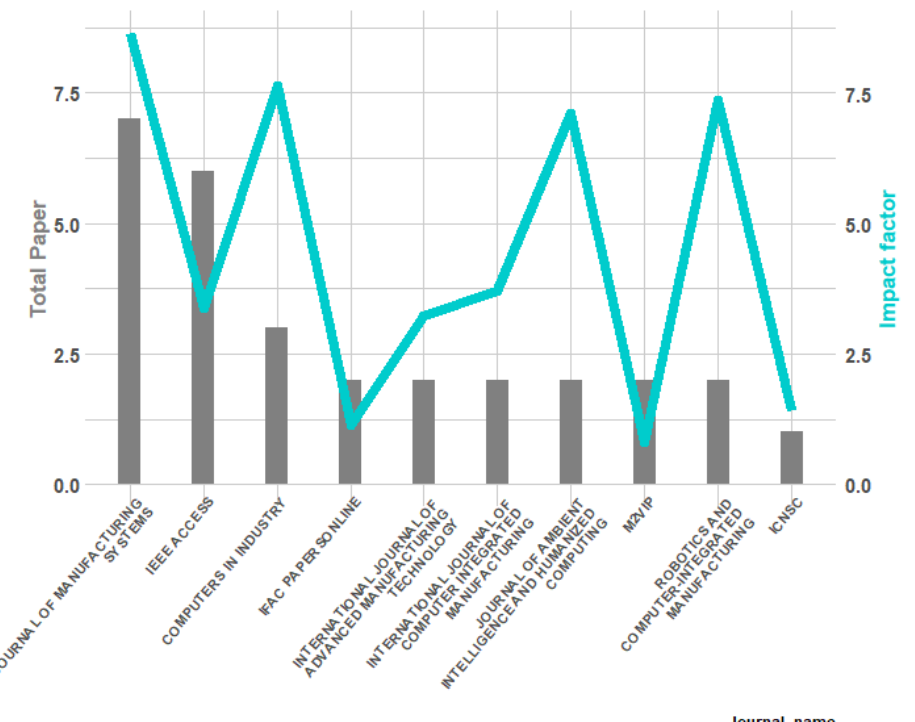
Figure 7. Top journal and conference productivity and impact factor. Top journal and conference productivity shown with bar chart and impact factor shown with line.